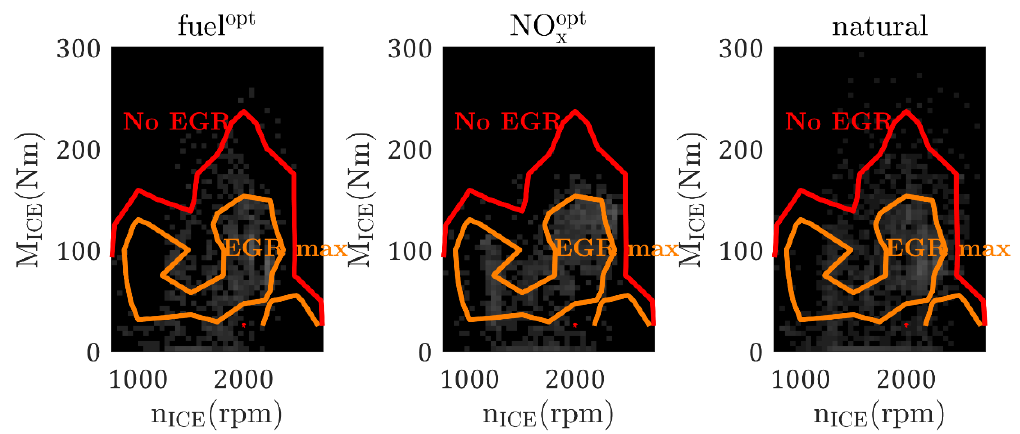
Figure 11. Distribution of engine operating conditions in the EGR opening map for the fuel optimal driving cycle ( left ), NOx optimal driving cycle ( center ) and natural driving ( right ). The color-scale represents the frequency of the operating conditions in the tested cycle from white (high frequency) to black (low frequency).